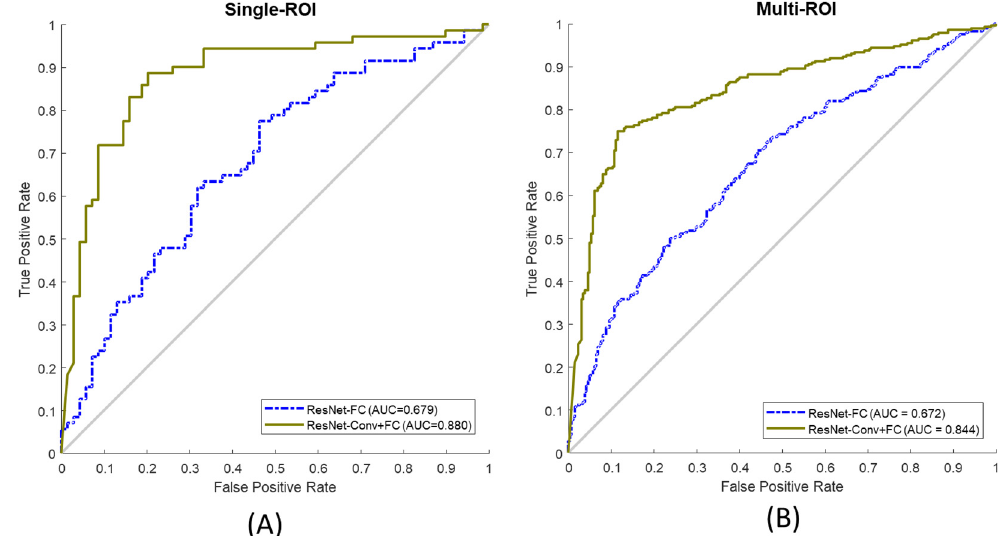
Figure 7. Training loss from three groups for ( A ) ResNet-FC and ( B ) ResNet-Conv+FC.